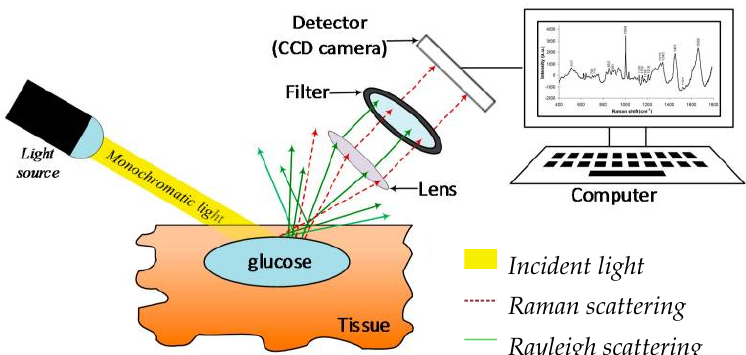
Figure 5. Scheme of a applied BGL measurement setup using Raman spectroscopy (Adapted from Ref. [77]).